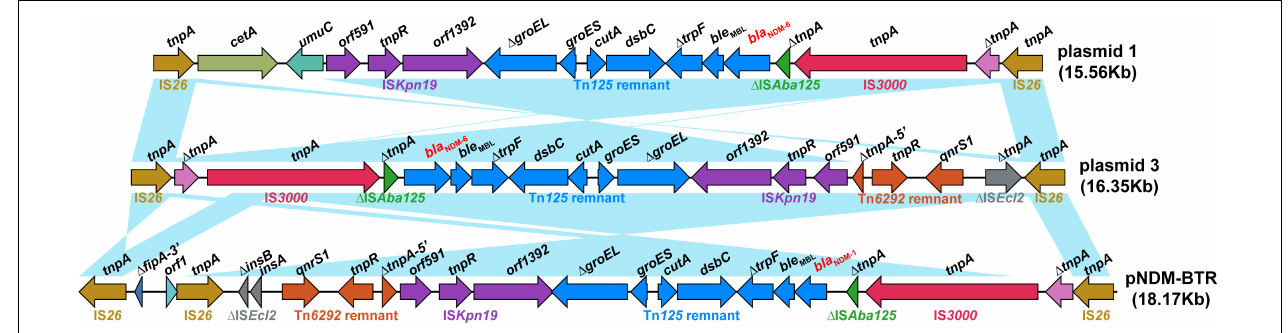
FIGURE 3 | Structure of the bla NDM − 6 region and flanking mobile elements. Linear genomic comparison between plasmid 1, plasmid 3, and pNDM-BTR (as a reference) of the conserved genetic context containing bla NDM . Open reading frames are denoted by arrows. Genes, mobile elements and other features are coloured based on their functional classification. Blue shading regions represent regions of homology (nucleotide identity, > 95%).